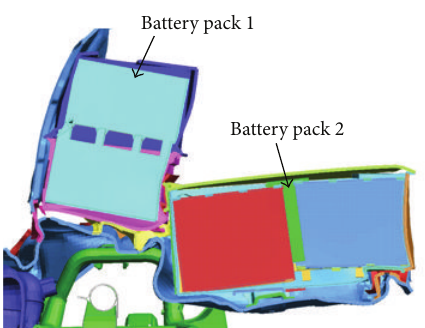
Figure 3: The impact simulation results of E-REV drive battery under rear-end collision test.